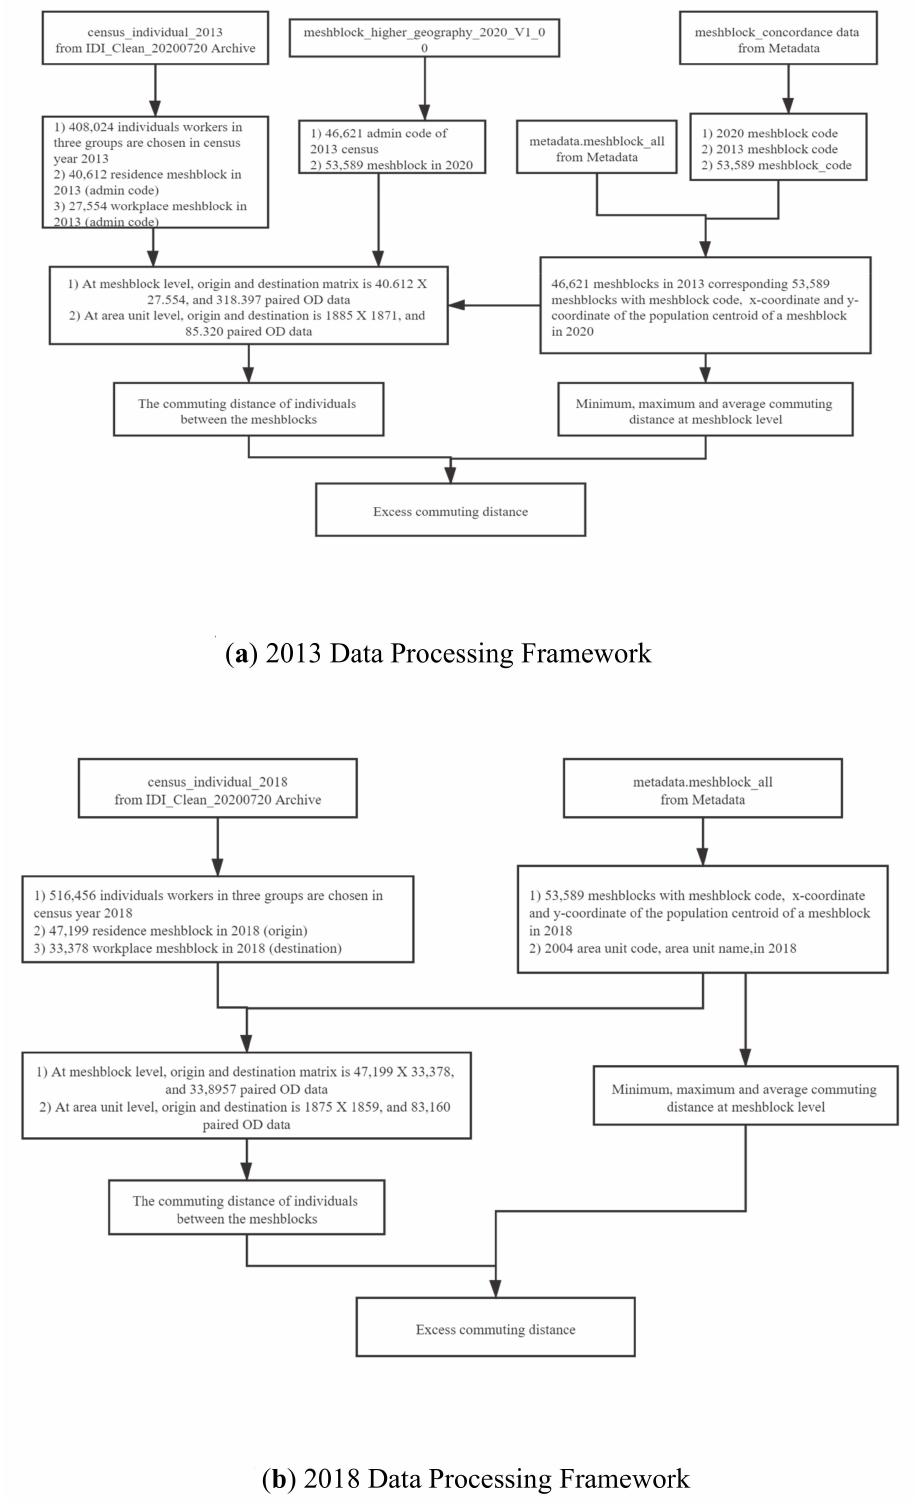
Figure 2. ( a ) and ( b ). Excess commuting data process framework by using IDI data for 2013 and